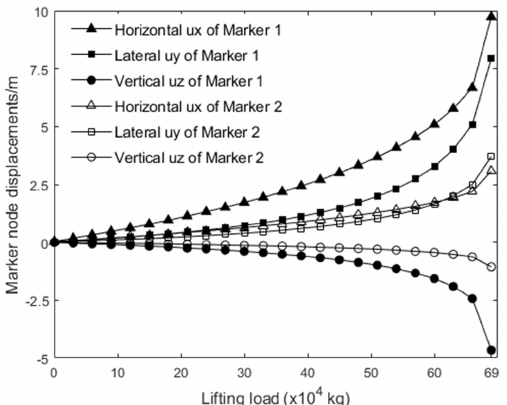
Figure 17. Load displacements of markers on a telescopic boom.